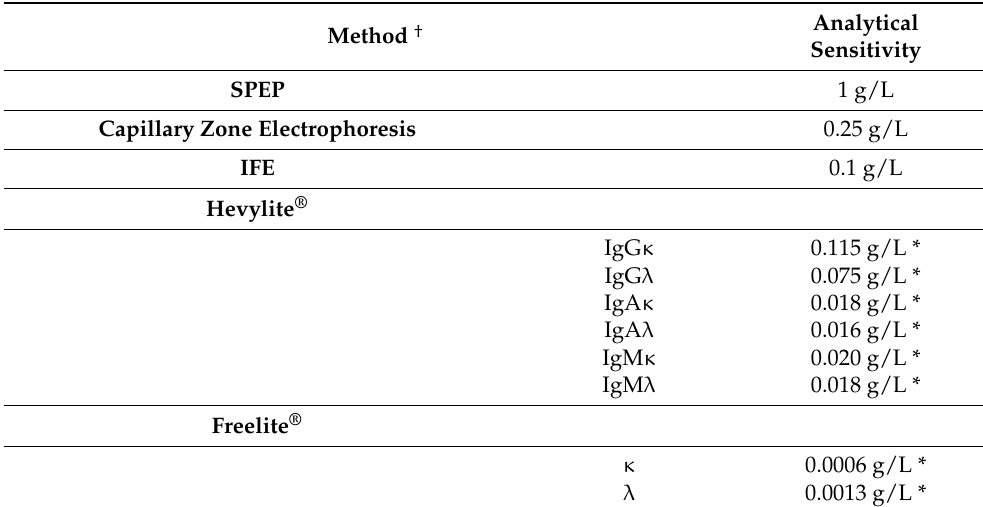
Table 3. Limit of detection of methods analyzing the monoclonal protein in